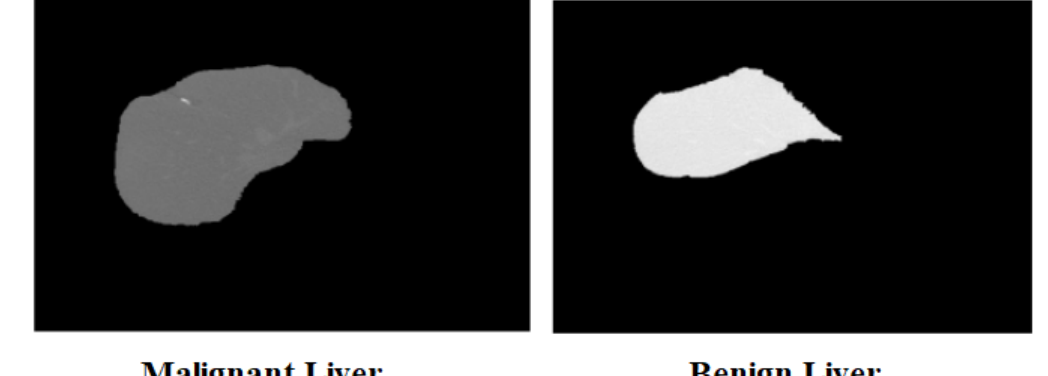
Figure 6. Sample label output of ELM classifier for input image.